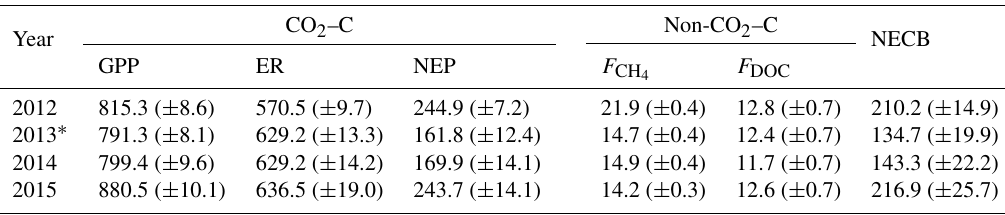
Table 1. Annual carbon balance and component fluxes ( ± estimated uncertainties, see Methods) at Kopuatai bog from 2012 to 2015 (all units are gCm − 2 yr − 1 ).